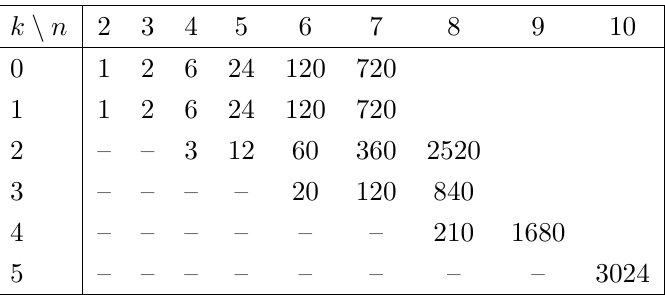
then computed to